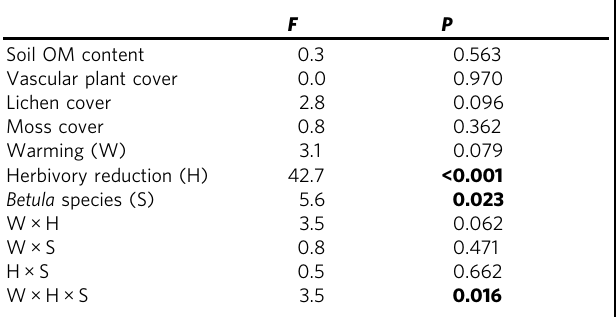
Table 1 Statistics of warming and herbivory effects on leaf damage